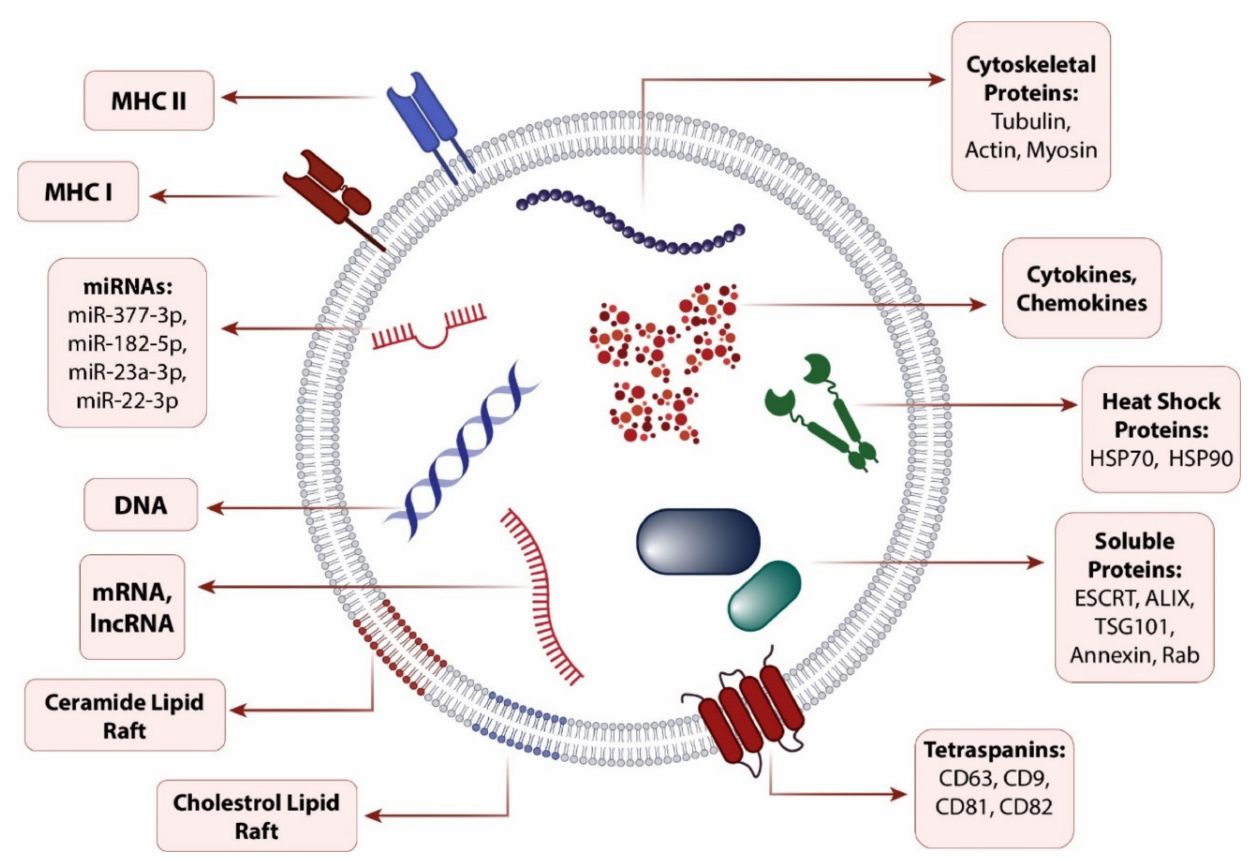
Figure 1. Exosome composition. Exosomes share a conserved cargo composition consisting of proteins, DNA, mRNAs, and miRNAs, which can be regulated according to the secreting cell type and its microenvironment. Abbreviations: MHC, Major histocompatibility complex; miRNA, microRNAs; lncRNA, long noncoding